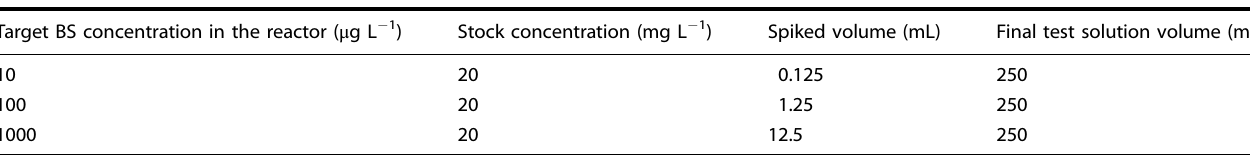
Table 3. BS test solutions and preparation.